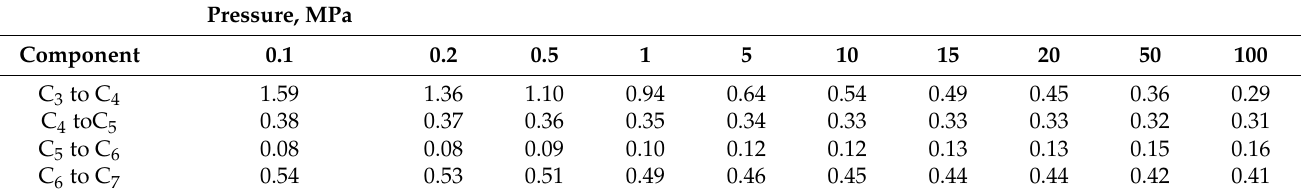
Table 19. ASF α value as a function of pressure for the gaseous hydrocarbons (Table